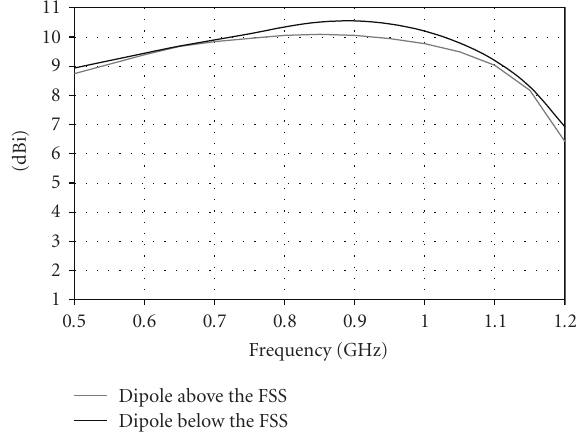
Figure 17: Radiation patterns in the H-plane. Figure 18, the directivity of the low profile EBG antenna excited by a dipole located under the FSS is the same as for previous result obtained with the dipole over the